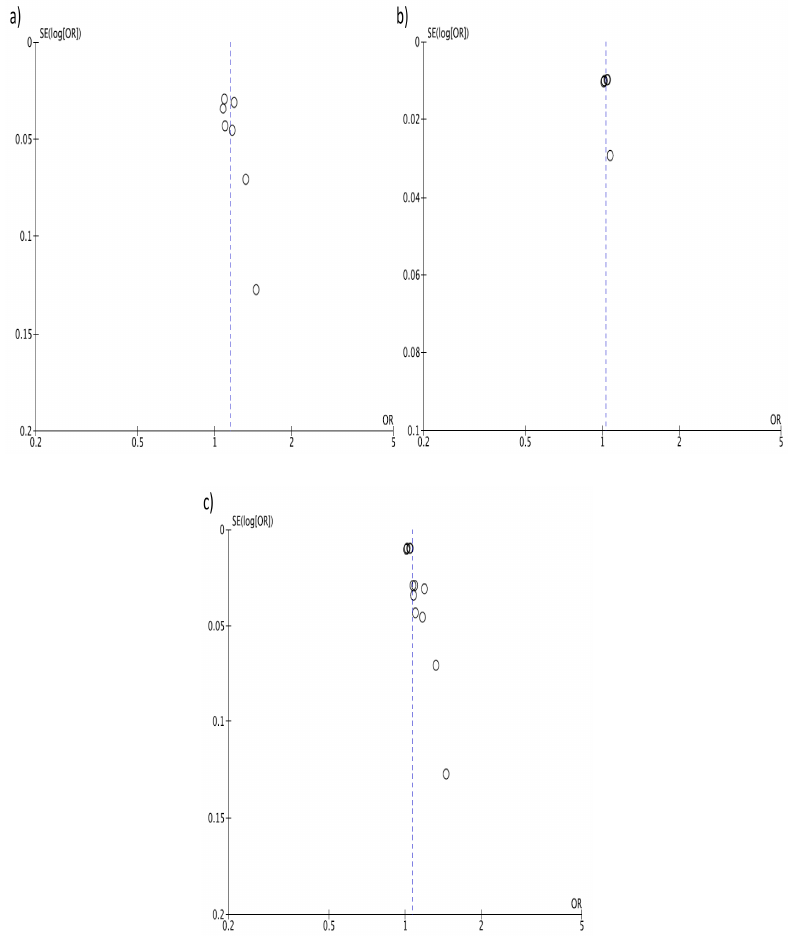
Figure 5. Funnel plots for colorectal cancer risk of a one-point increase of Dietary Inflammatory Index (DII): ( a ) case-control, ( b ) prospective, and ( c ) total